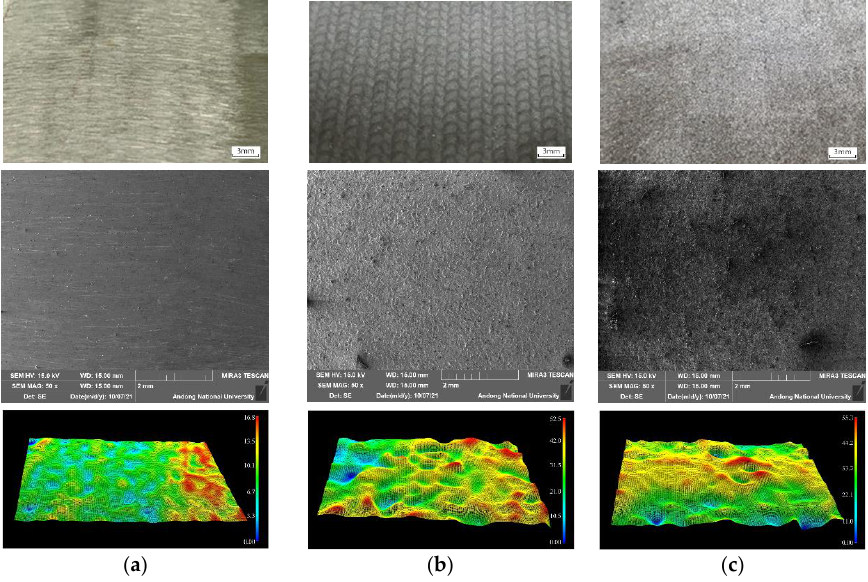
Figure 4. The surface appearance of 304L stainless steel after LP; ( a ) 304L(nonpeened), ( b ) 304L-L-NC (laser-peened without Al coating), and ( c ) 304L-L-WC (laser-peened with Al